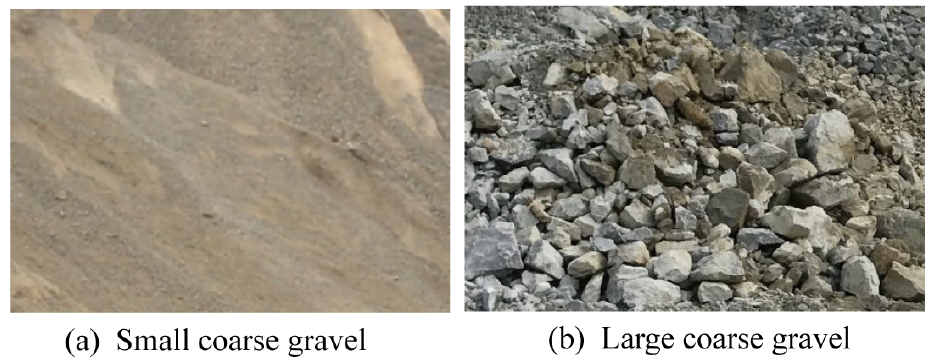
Figure 5. Two operating materials.